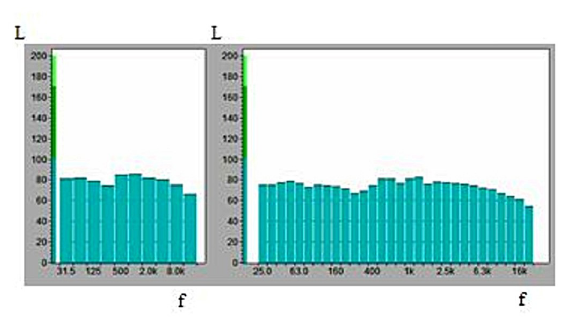
Figure 3: Diagram of spectral characteristics of sound levels for point 2 of measurements (octave and 1/3 octave